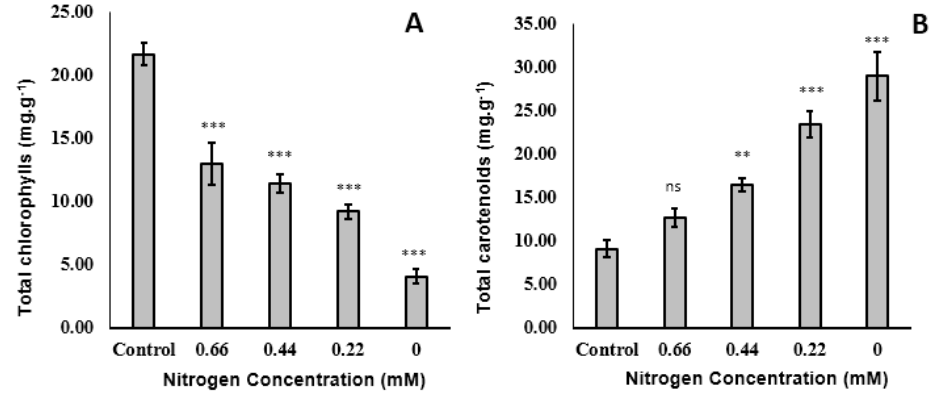
Figure 4. Contents of total chlorophyll ( A ) and carotenoids ( B ) in Tisochrysis lutea grown mixotrophically in different concentrations of NaNO 3 . ** p < 0.01, *** p < 0.001, ns: not significant with respect to the control (0.88 mM).